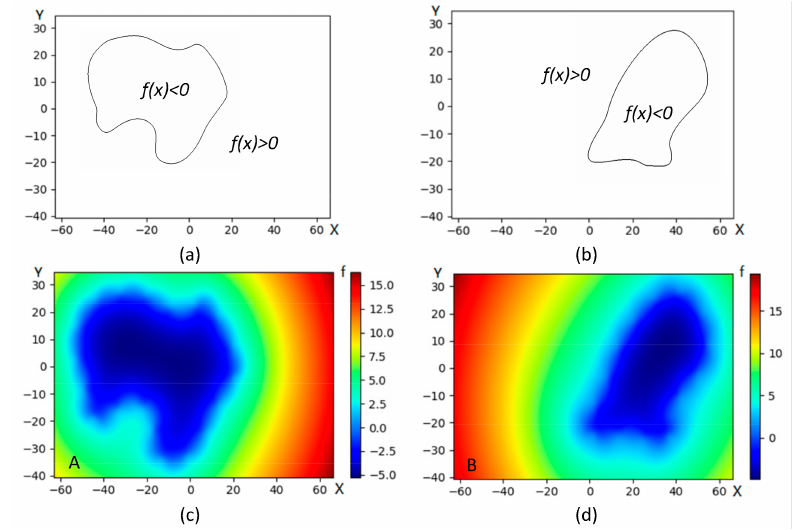
Figure 1. Schematic diagram of two signed distance fields ( c , d ) interpolated from two contours ( a , b ). The range of signed distance values corresponds to the color